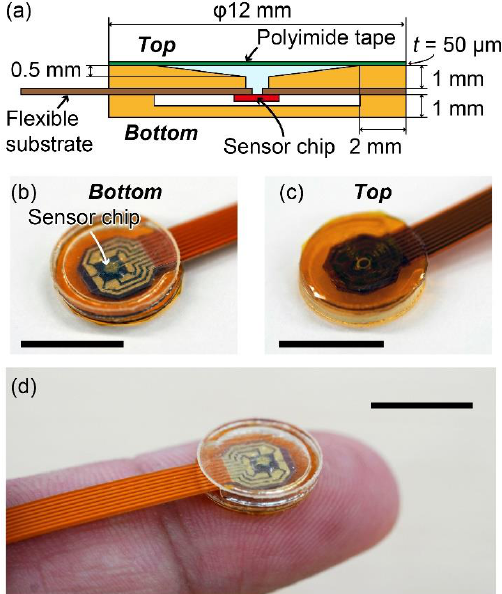
Figure 3. ( a ) Structure of the sensor. ( b , c ) Photographs of the bottom and top surfaces of the fabricated sensor. ( d ) Photograph of the sensor placed on an index finger. The scale bars in ( b – d ) are 1